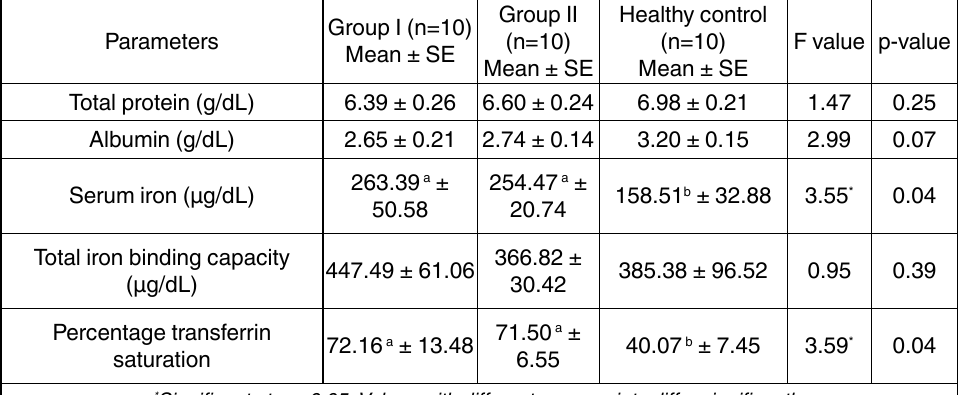
table 2 . Serum biochemical parameters of dogs with non-regenerative anaemia associated with Babesia gibsoni infection